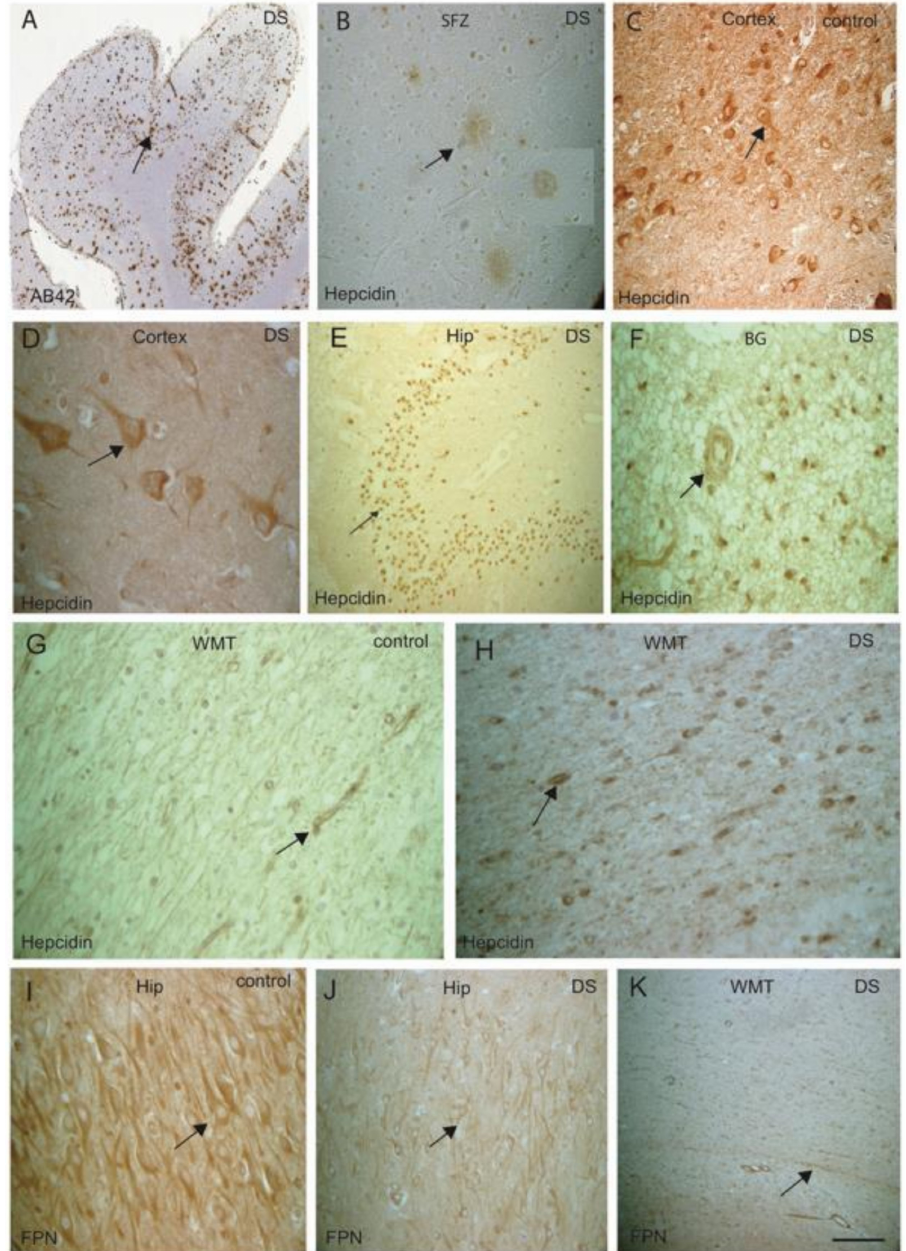
Figure 3. Hepcidin and ferroportin expression in the oligodendrocytes of white matter tract. DS brain sections from SFG stained with DAB, anti-A β 42 and hepcidin antibody revealed strong signal of SPs, positive for A β 42 and visible throughout the cortex ( A , black arrows highlighting the selected area of plaque formation), hepcidin was visible in SPs ( B ). In control brains (cortex), abundant hepcidin was seen in the neurons and in the neuropils ( C ); in contrast, in the DS cortex, hepcidin staining was faint, present only in neurons and glial cells ( D ). In DS brain, hepcidin was present in the dentate gyrus